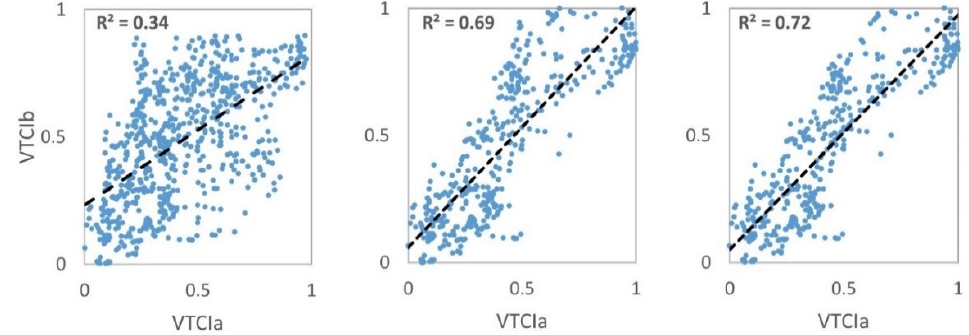
Figure 7. Example of vegetation temperature condition index (VTCI) calculations between day of year (DOY) 243-257 ( a ) before any modifications and ( b ) after adding selective filter, and ( c ) after adding NDVI-based coefficient.